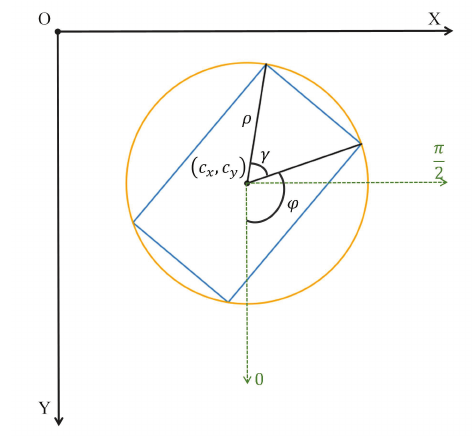
Figure 5. Proposed polar representation of